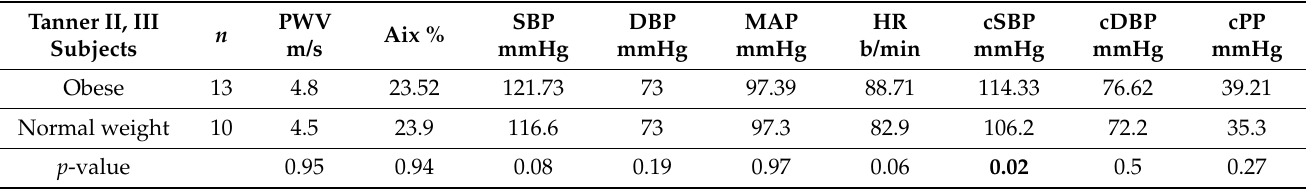
Table 11. PWA parameters comparison in Tanner Stage II and III subjects.